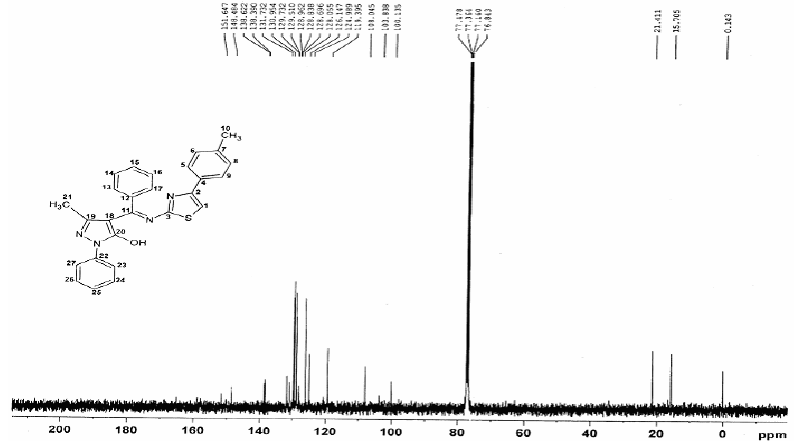
Figure 7 . 13 C NMR spectra of BzPMPAMPT